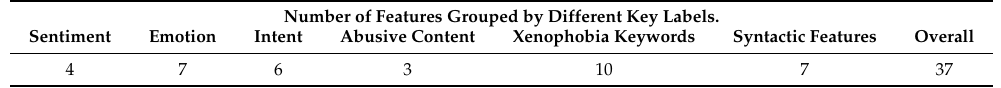
Table 4. Distribution of the features presented in our INTER feature representation. The overall column shows the total number of features.